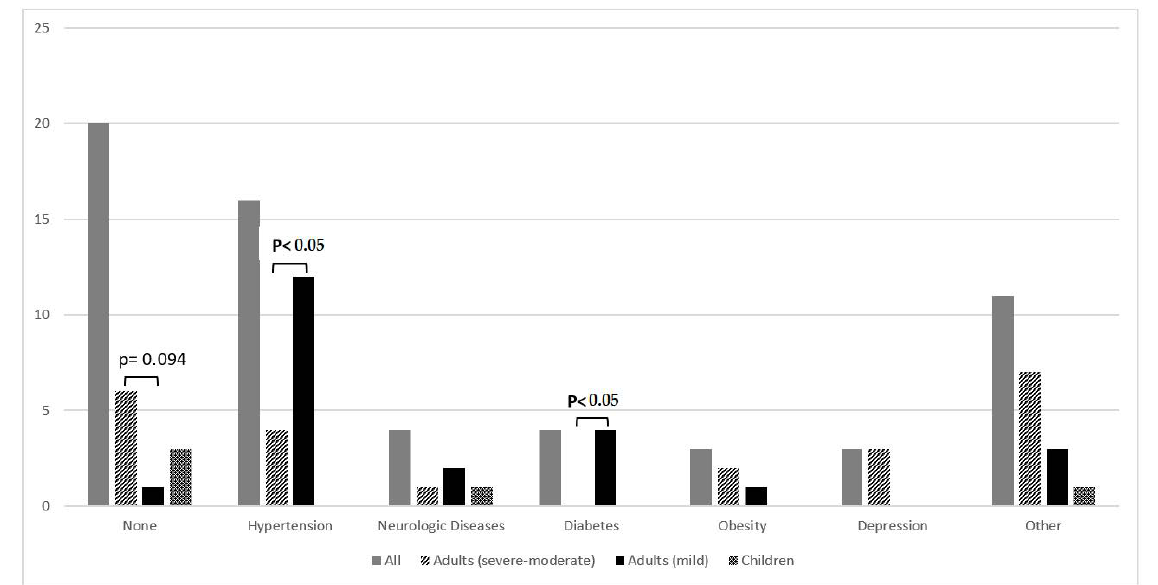
Figure 1. Concomitant diseases reported at ICH onset. 11 of 26 patients presenting other diseases had two or more comorbidities. Prophylaxis Neurosurgical interventions for evacuation of the cerebral haematoma were carried out in 45.7% of cases while 76.7% of patients received treatment with factor FVIII, FIX or rFVIIa for at least three weeks from the ICH onset. Eight patients died immediately